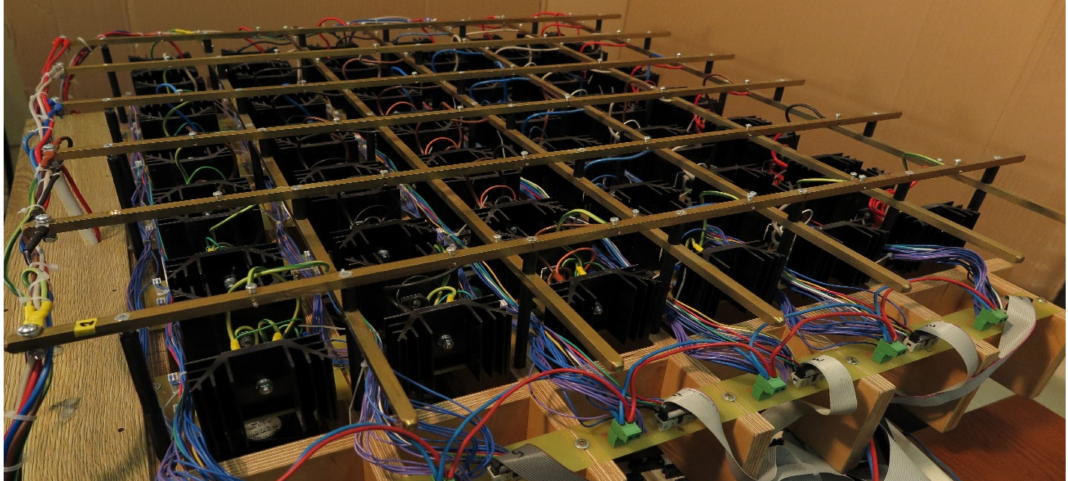
Figure 14. The 30 kVA-rated MMC laboratory model of the 6 × 6 structure used for evaluation of the converter